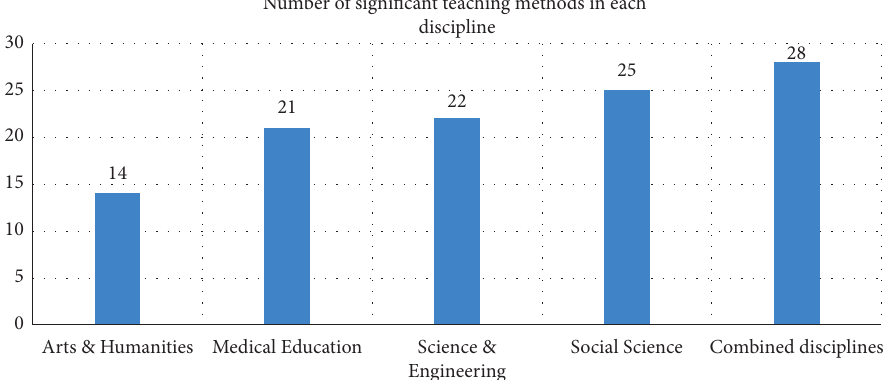
Figure 3: Number of significant TMs in each